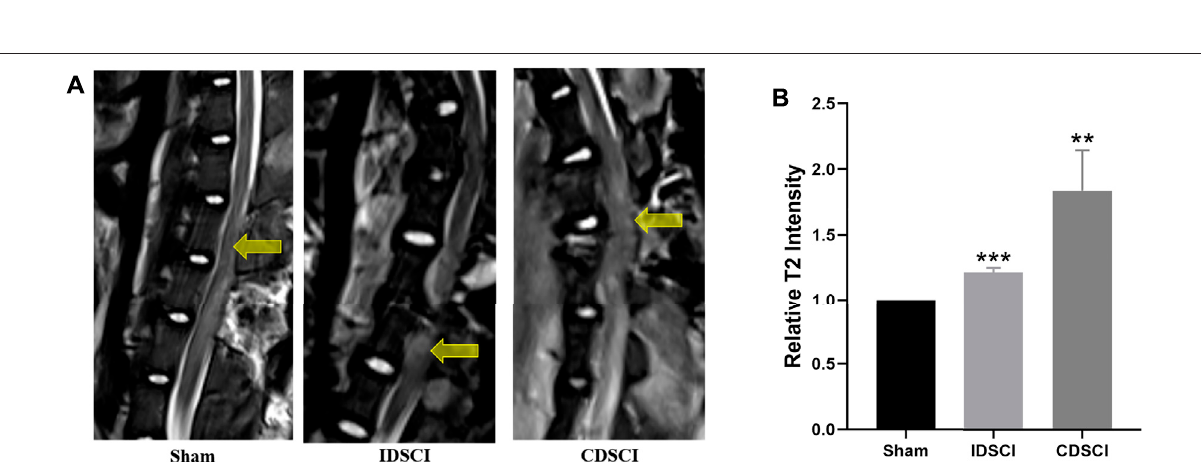
Frontiers in Cell and Developmental Biology |